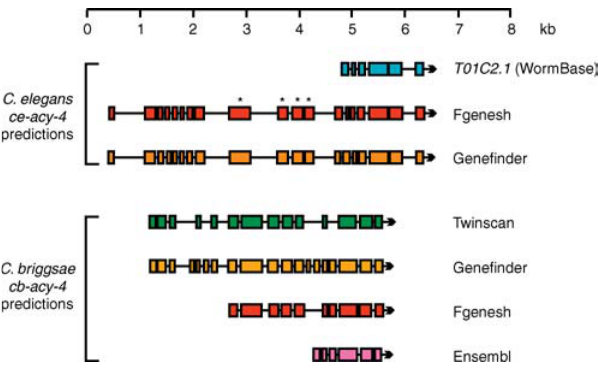
Figure 1. Joint Refinement of C. elegans and C. briggsae Gene Models: acy-4 When annotating the C. briggsae and C. elegans acy-4 orthologs, we chose the Genefinder ce-acy-4 prediction and the Genefinder cb-acy-4 prediction because, out of the 12 possible combinations of a C. briggsae and a C. elegans prediction, this pair shows the most similarity to each other. Coding sequence (CDS) conservation between cb-acy-4 and ce-acy-4 provides evidence for as many as 12 additional N- terminal exons in the Genefinder ce-acy-4 prediction, as compared to T01C2.1 , the WS77 ce-acy-4 prediction. Subsequently, four of the additional N-terminal exons that were predicted by FGENESH and Genefinder were confirmed by new EST data (marked with asterisks). DOI: